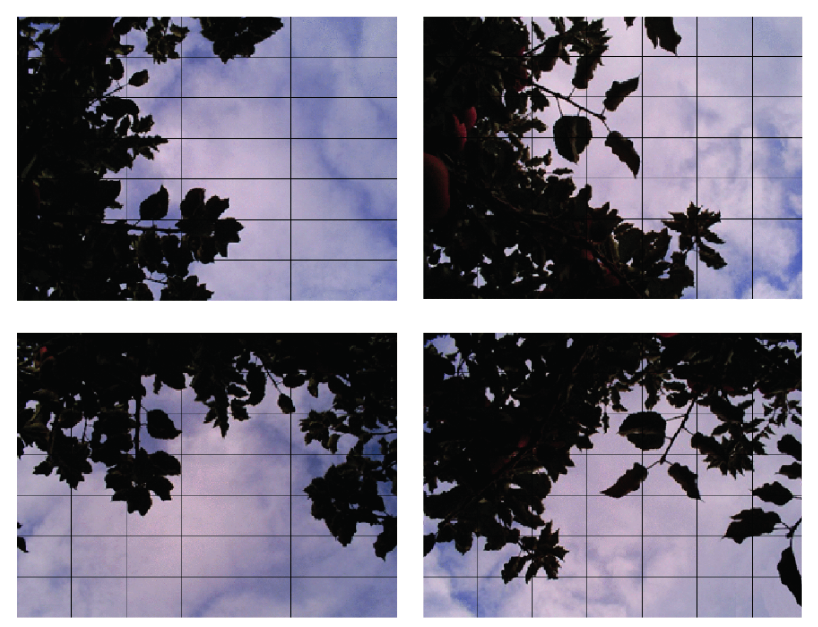
Figure 1. Example of typical upward looking digital images for an apple tree, considering the four quadrants defined with an image sub-division of 7 (49 sub-samples per each